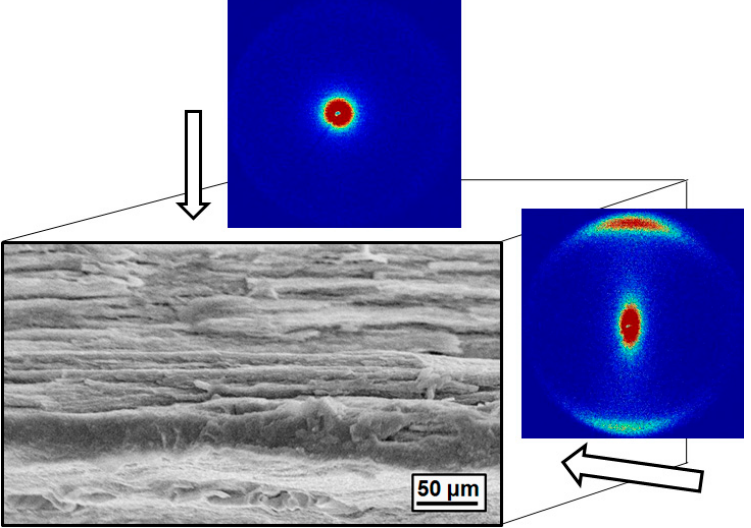
Figure 14. Schematic of a PEO-MMT film, containing Li 2 SO 4 , that was prepared through a layer-by-layer approach. The exposed freeze-fractured edge was analyzed via SEM and a micrograph is displayed. Additionally 2D SAXS patterns are presented for the cases when the X-ray beam is projected on the edge and on the top surface of the